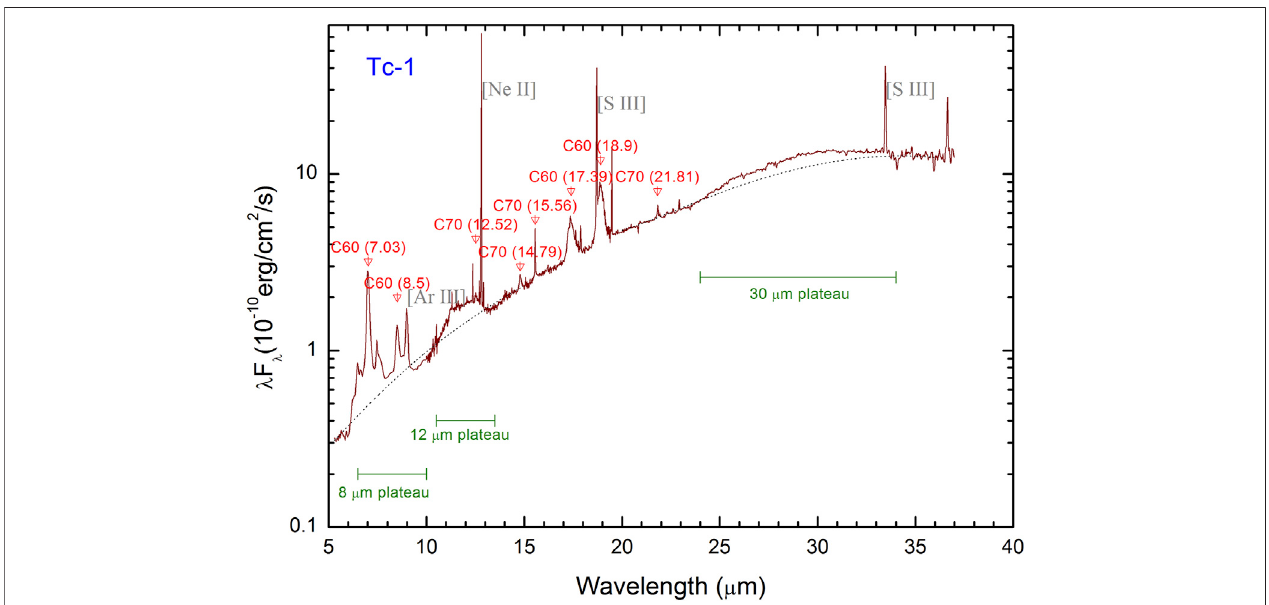
FIGURE 1 | Spitzer IRS spectrum of planetary nebula Tc-1 shows C 60 and C 70 emission bands (in red) as well as broad emission plateau features at 8, 12, and 30 µm (in green). The narrow lines are atomic lines (in grey). The dotted line represents an approximate fi t to the continuum. No UIE bands are seen in this object.